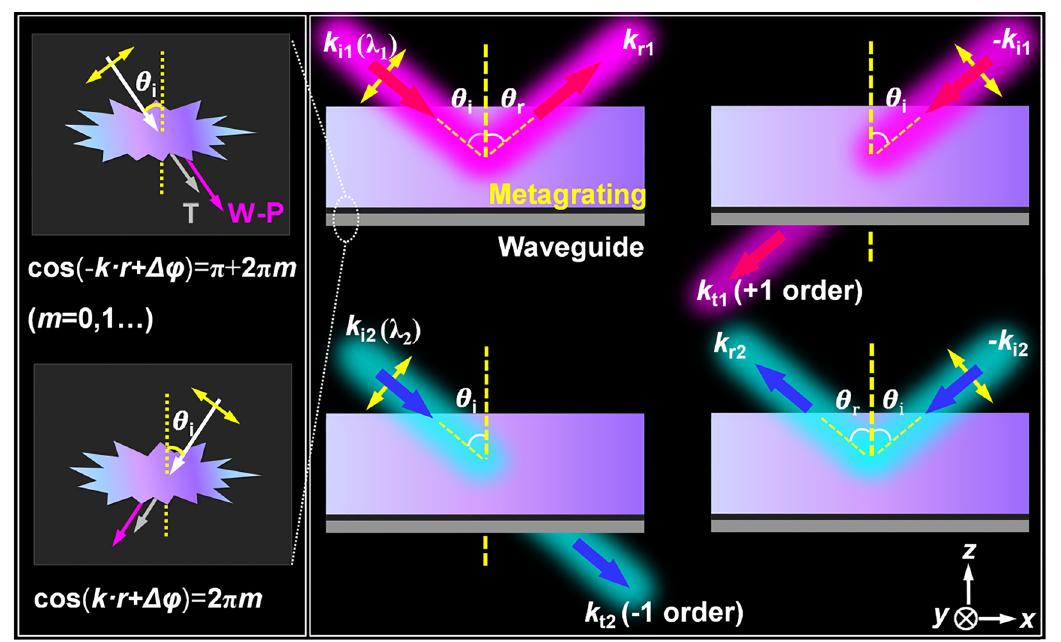
Figure 1: Physical origin and schematic diagrams of the Fano-resonance-assisted directional color routing in waveguide-bimetallic